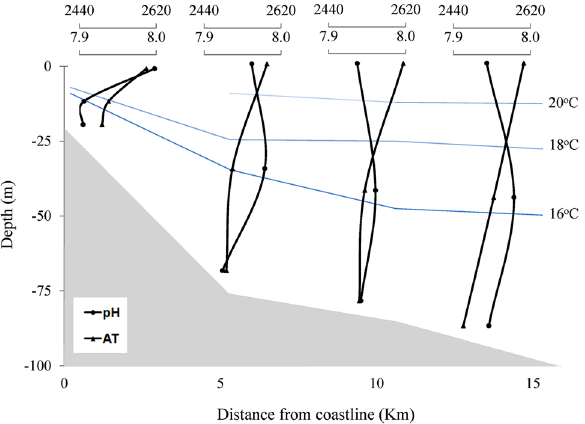
Figure 8. pH and Alkalinity of the longitudinal samples from the surface, middle, and bottom water